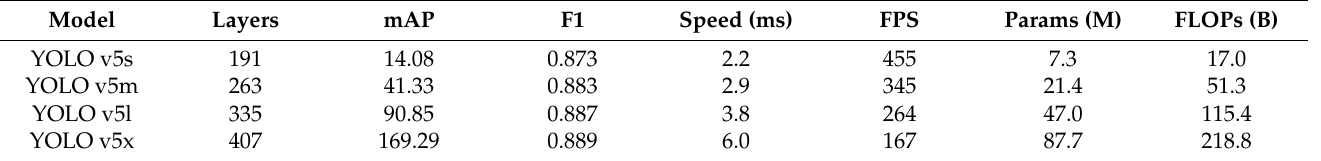
Table 4. Comparison of different versions of the model parameters of YOLO v5 (general evaluation indicators, such as speed and FLOPs of different versions of the